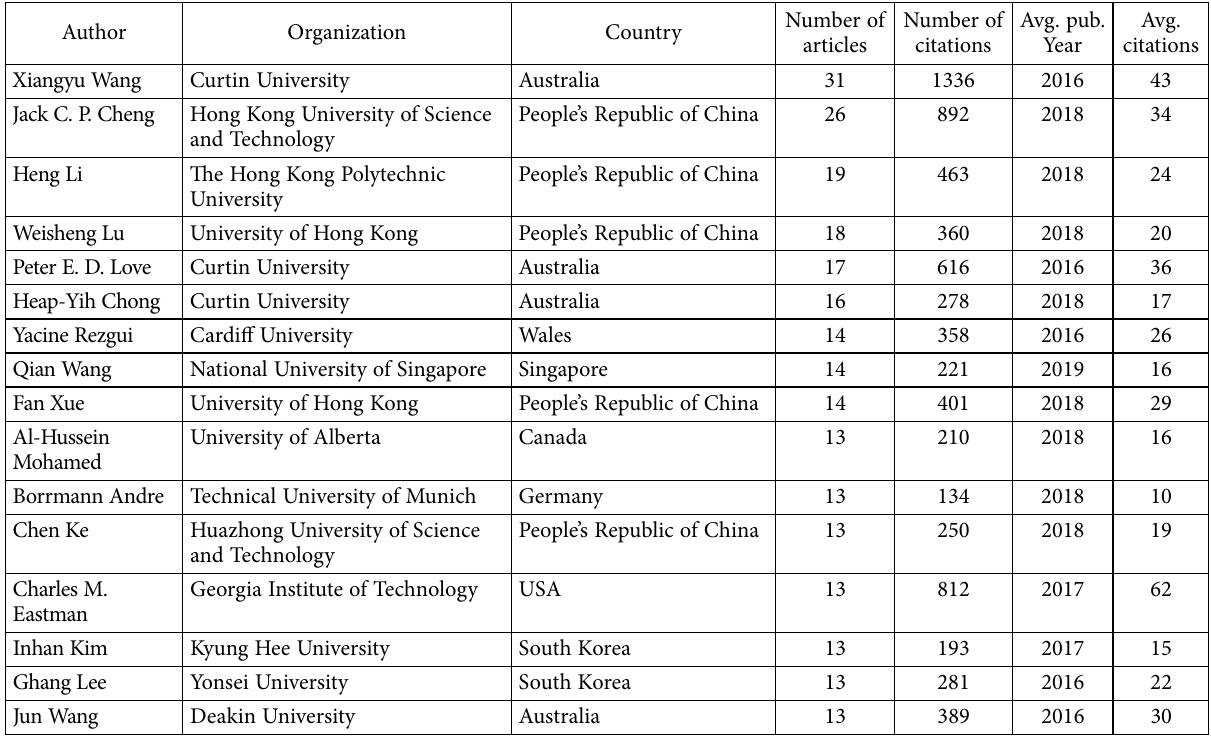
Table 1. Quantitative measurement of